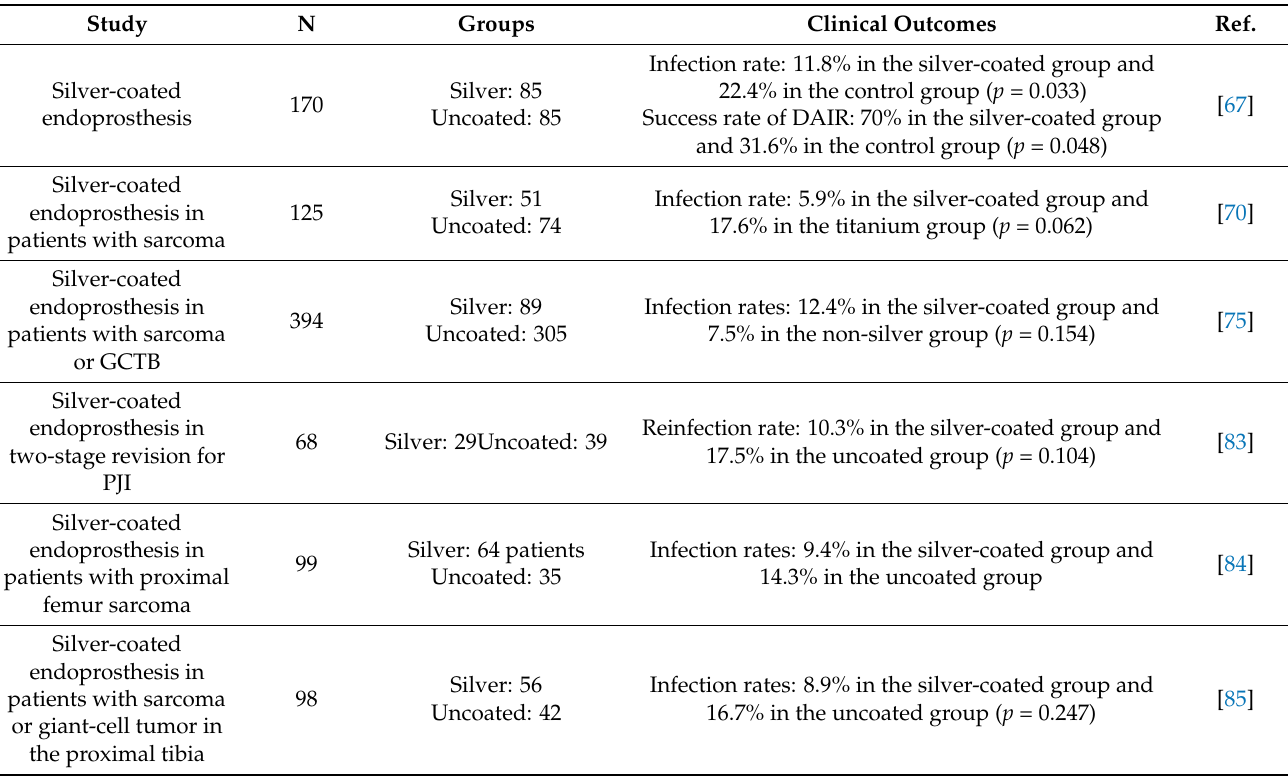
Table 3. Antibacterial coating techniques for the prevention of SSI during bone tumor surgery. Clinical Outcomes